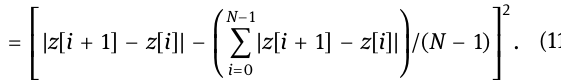
Figure 4: Comparison of curves of 40 Hz and 600 μ m amplitude acquisition data fi